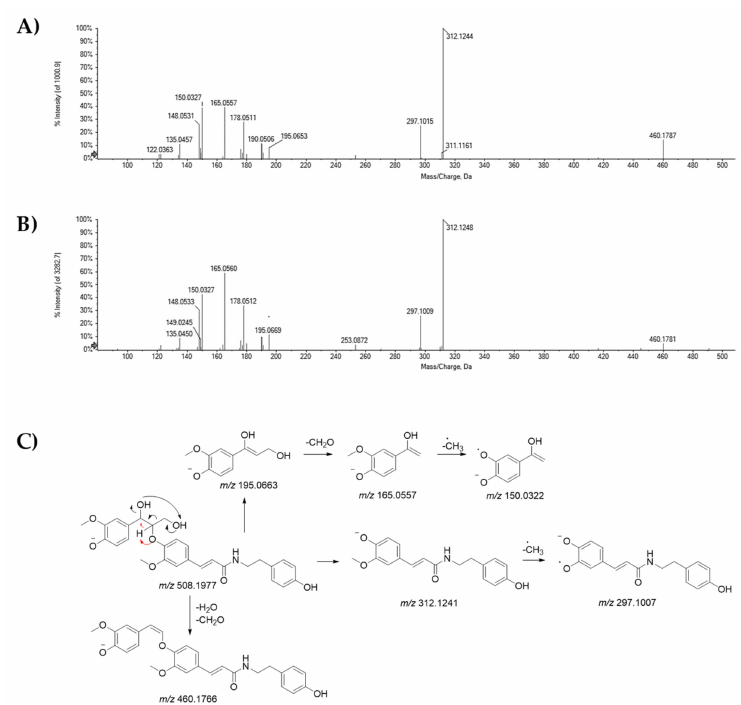
Figure 4. TOF-MS / MS spectra of compounds ( A ) 19 and ( B ) 20 , tentatively identified as cannabisin H isomers. The proposed fragmentation pathway of their [M − H] − ion was reported ( C ); the theoretical m / z value is reported below each